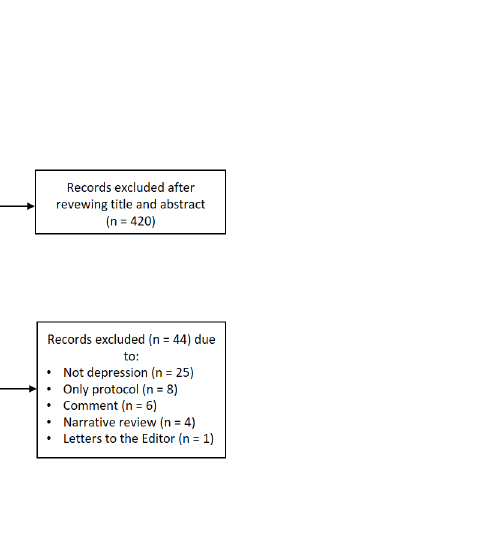
Fig 1. Flow diagram of meta-analysis